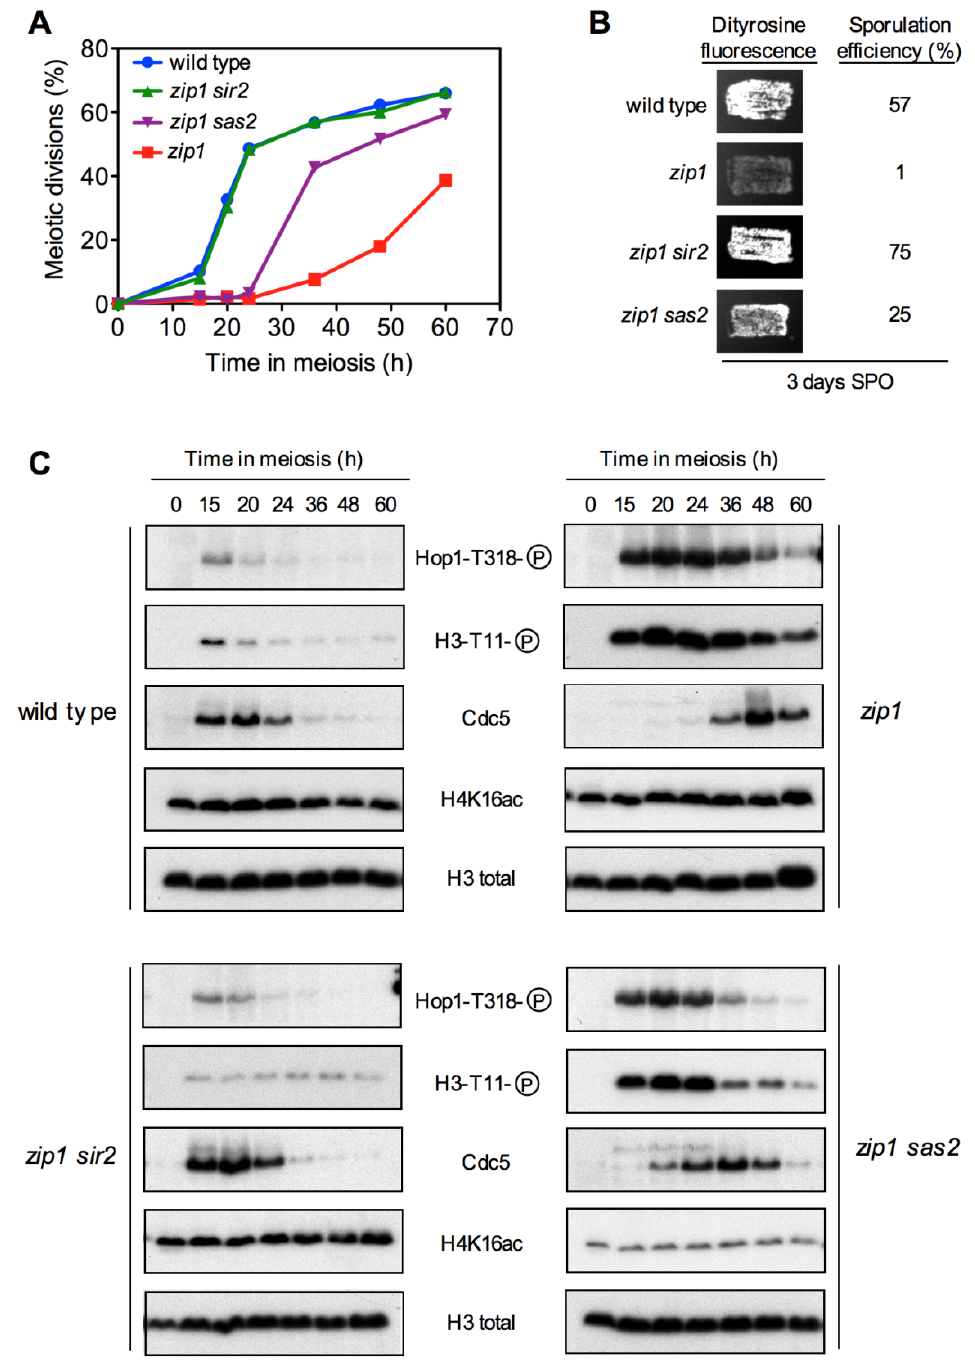
FIGURE 6: The meiotic recombination checkpoint response is impaired in the absence of Sir2 or Sas2. (A) Time course of meiotic nuclear divisions; the percentage of cells containing two or more nuclei is represented. (B) Dityrosine fluorescence, as a visual indicator of sporula- tion, and sporulation efficiency, quantified by microscopic examination of at least 300 cells, were examined after 3 days of sporulation on plates. (C) Western blot analysis of the indicated proteins during meiosis. Strains are DP421 (wild type), DP422 ( zip1 ), DP1401 ( zip1 sir2 ) and DP1410 ( zip1 sas2 ) OPEN ACCESS | www.microbialcell.com